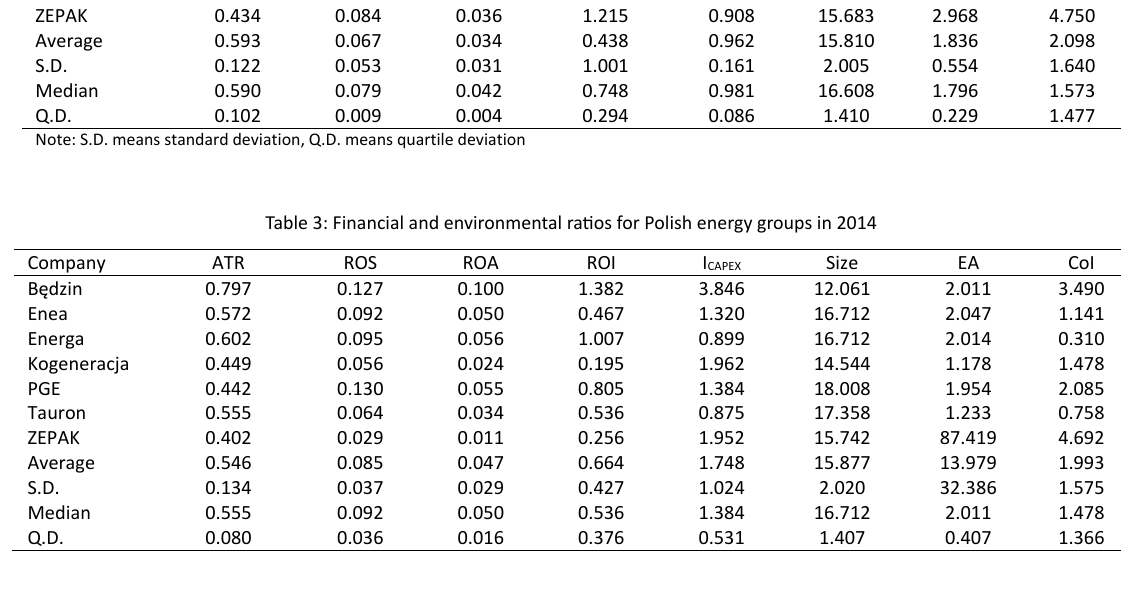
Table 4: Financial and environmental ratios for Polish energy groups in 2015